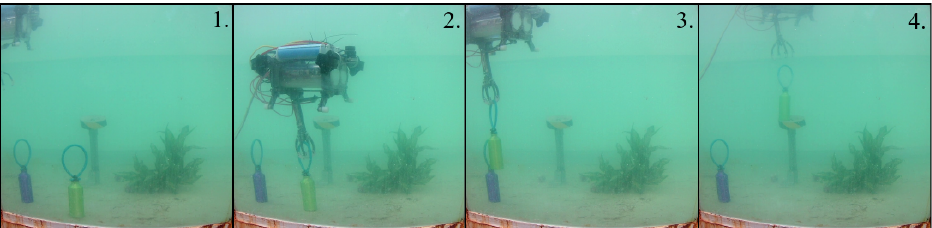
Figure 17. Practical results of catching the bottle. The numbers are given according to the proposed stages in the methodology.